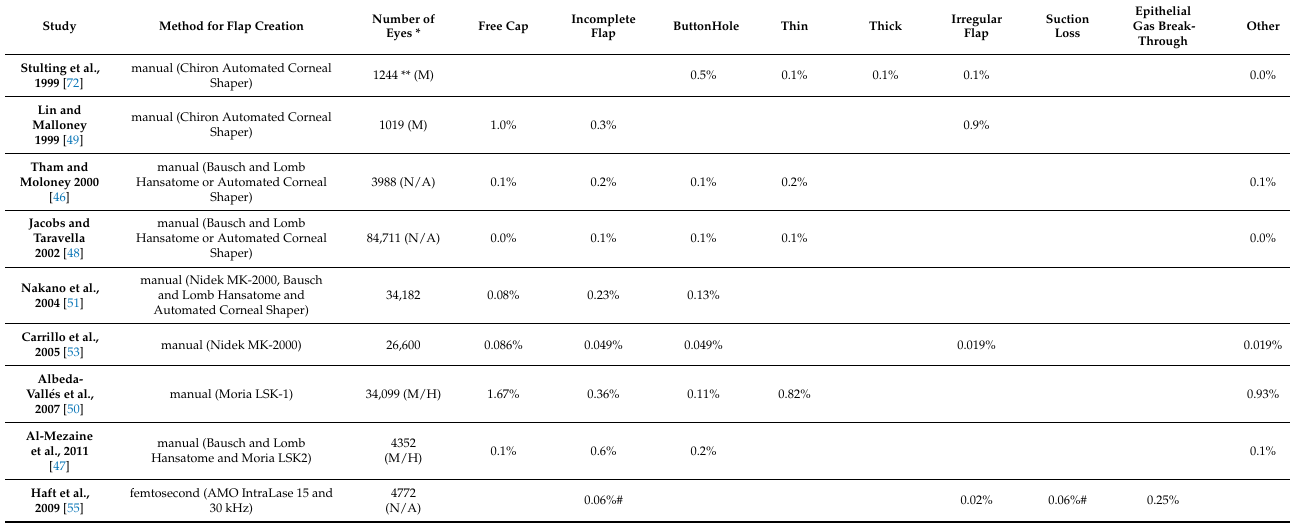
Table 1. Large clinical studies that analyze the rate of intraoperative flap complications in manual and femtosecond flap creation. The total risk of complications is stated only if calculated within the